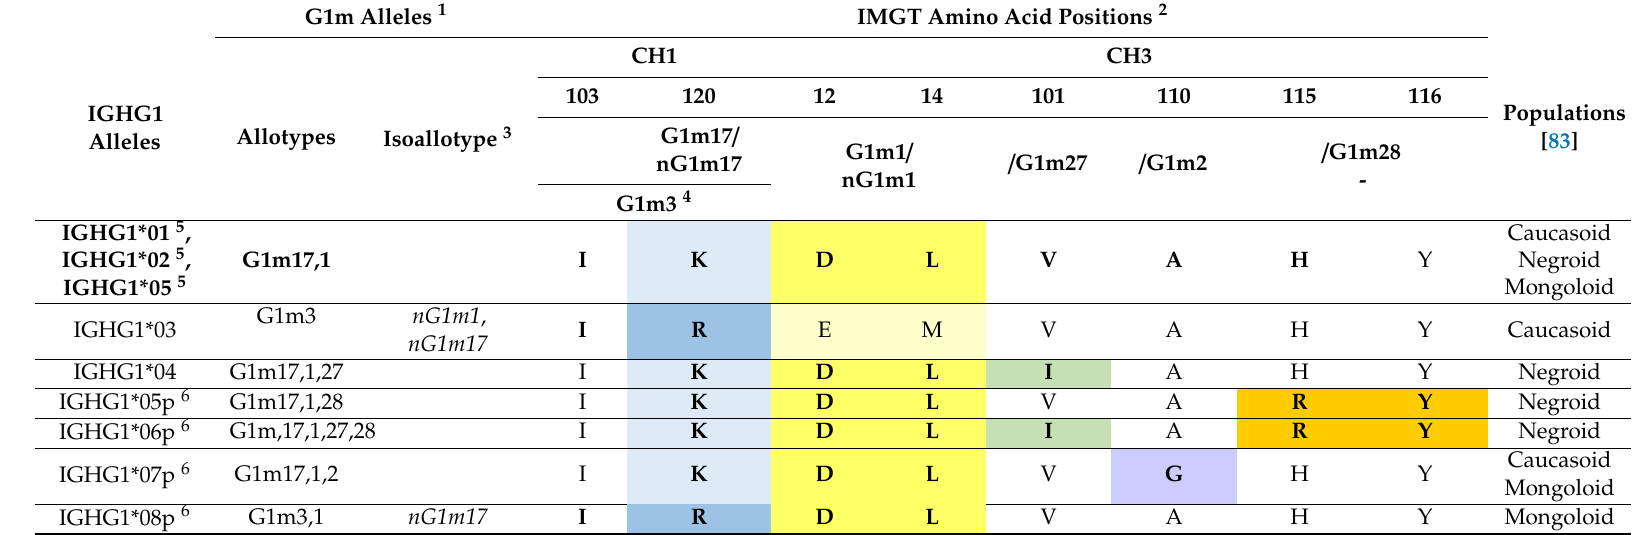
Table 14. Correspondence between the IGHG1 alleles and G1m alleles